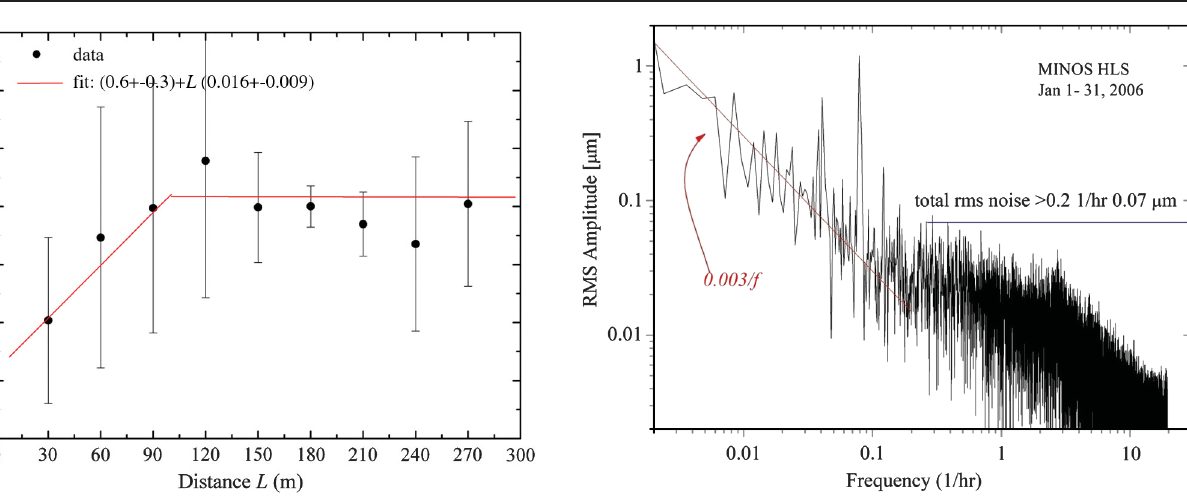
FIG. 38. (Color) Dependence of the growth rate of the variance of the 2nd difference vs distance between the HLS probes in the Tevatron tunnel, the week of February 7, 2004 (from Ref. [30]).